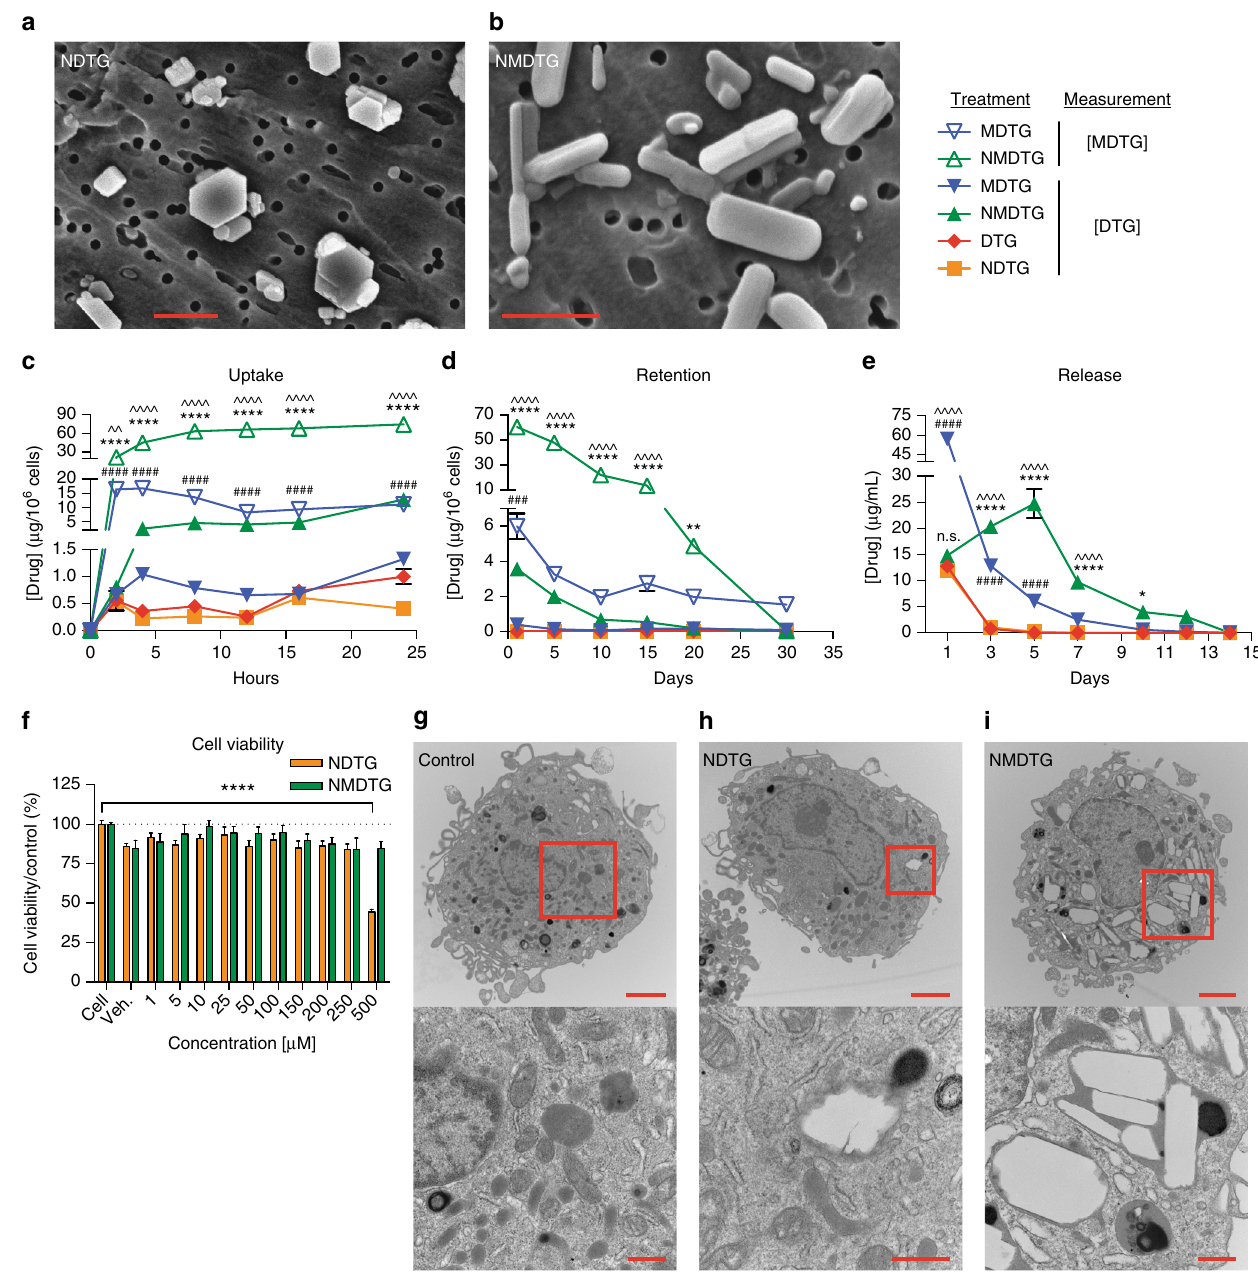
Fig. 3 Nanoparticle characterization. a , b Particle morphology was assessed by scanning electron microscopy (SEM). a Note that NDTG particles are of heterogeneous size and shape, and show both cuboidal and rod-shaped morphologies. b NMDTG particles are more uniform, with dominant rod-shaped morphologies (scale bars = 1 µ m). c Drug uptake in MDM was measured over a 24-h period with equal drug concentrations (100 µ M). Uptake of NMDTG was at or more than a half-log greater than its nonmodi fi ed control. **** P < 0.0001 NMDTG vs. NDTG. #### P < 0.0001 MDTG vs. DTG. ^^ P = 0.0054, the NMDTG compared to the nonmodi fi ed control. ** P = 0.0048, **** P < 0.0001 NMDTG vs. NDTG. ### P = 0.0004 MDTG vs. DTG. ^^^^ P <